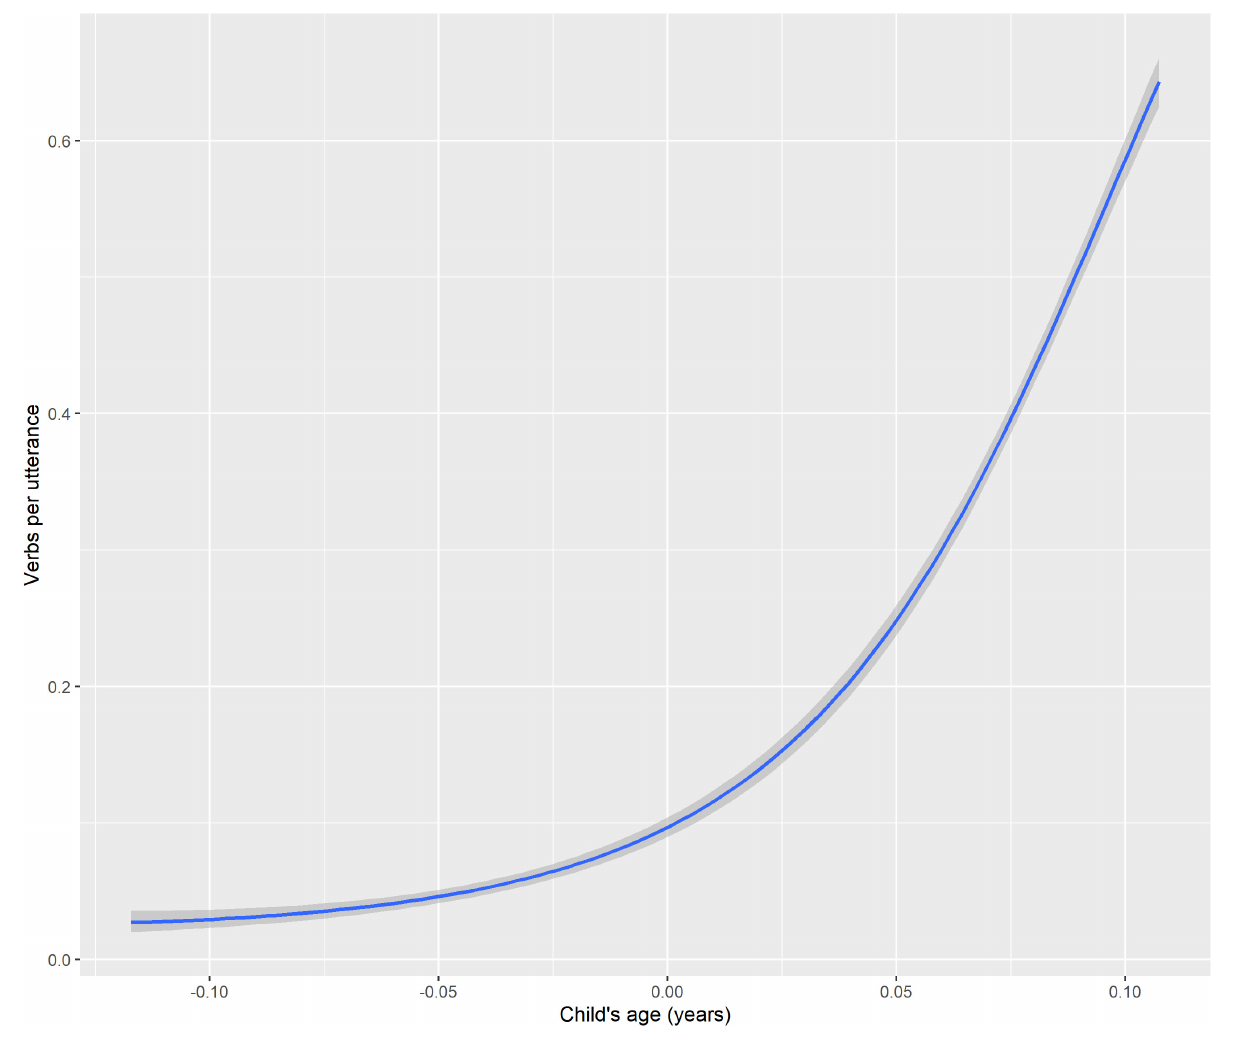
FIGURE 8 | Conditional effects of child’s age and age ∧ 2 on verb/utterance